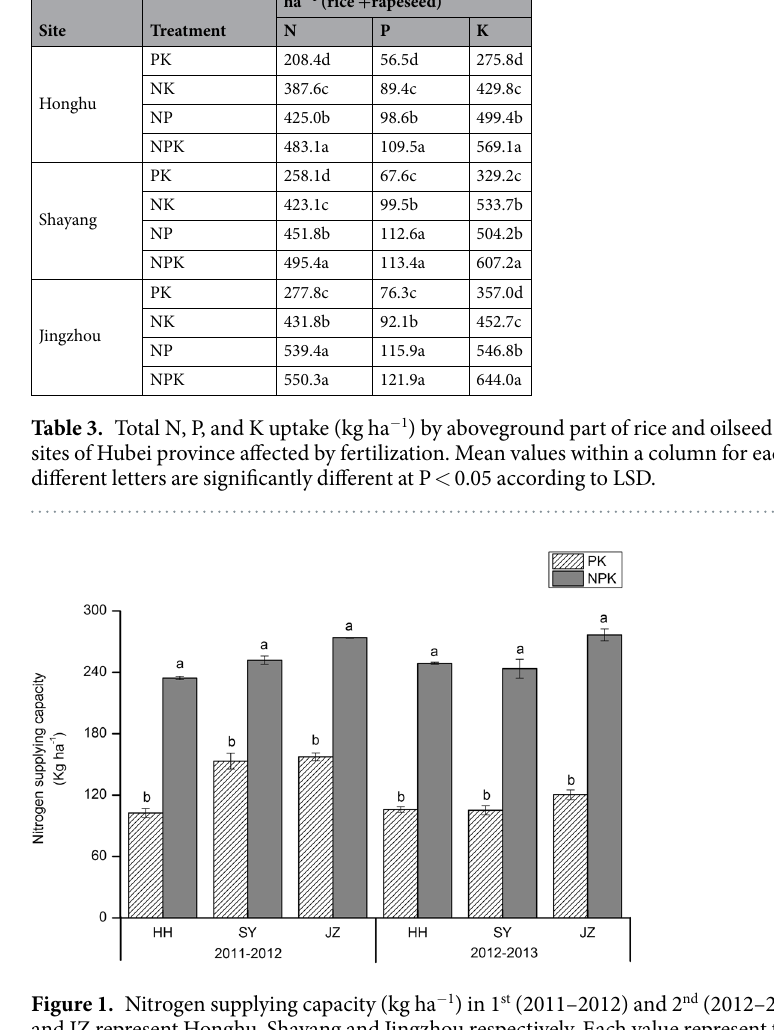
Figure 1. Nitrogen supplying capacity (kg ha − 1 ) in 1 st (2011–2012) and 2 nd (2012–2013) rotation. HH, SY and JZ represent Honghu, Shayang and Jingzhou respectively. Each value represent the standard error ( n = 3). Within a season, bars with different letters are significantly different at P < 0.05 according to LSD.